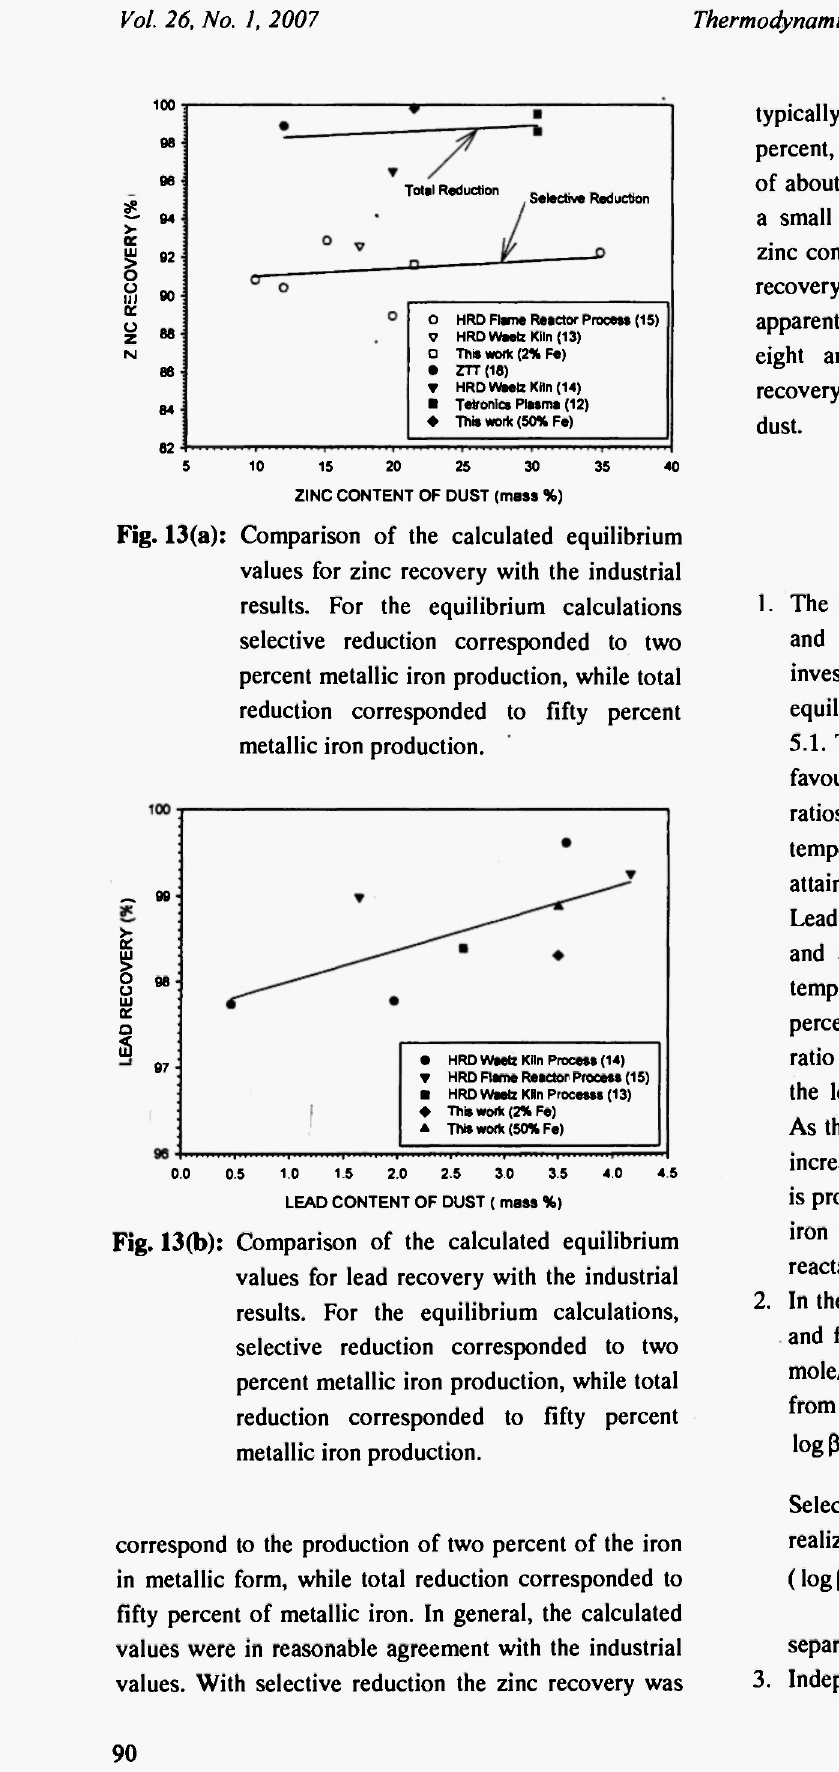
Fig. 13(b): Comparison of the calculated equilibrium values for lead recovery with the industrial results. For the equilibrium calculations, selective reduction corresponded to two percent metallic iron production, while total reduction corresponded to fifty percent metallic iron